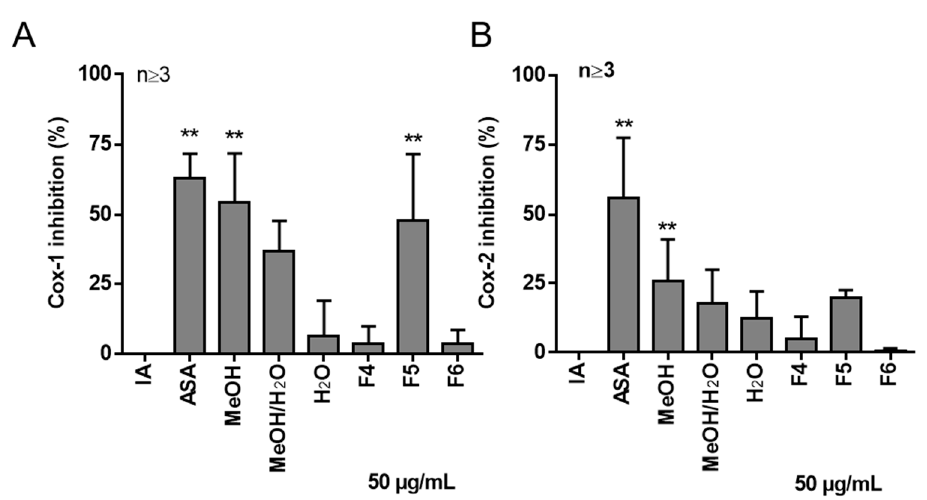
Figure 2. Effects of Salix extracts and SPE fractions on COX-1/2 enzyme activity. Human recombinant COX-1 ( A ) or COX-2 ( B ) enzyme activity was analyzed based on the quantification of prostaglandin PGF2 α (formed by the SnCl 2 reduction of COX-derived PGH 2 ) using an ELISA (Enzyme-Linked Immunosorbent Assay) assay. Inhibition (%) was calculated by comparison to the initial activity (IA) of the COX-1 or COX-2 protein. ASA, acetyl salicylic acid. Bars are the means + SD. Asterisks indicate statistically significant differences between the respective treatment and the solvent control. ** p < 0.01.